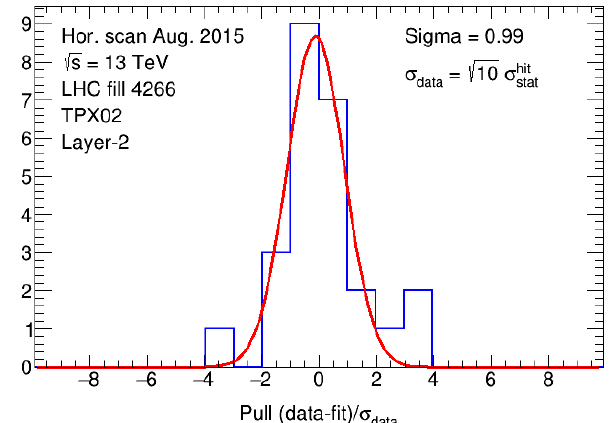
√ R · σ hit , with R = N hit / N cl = 10 stat